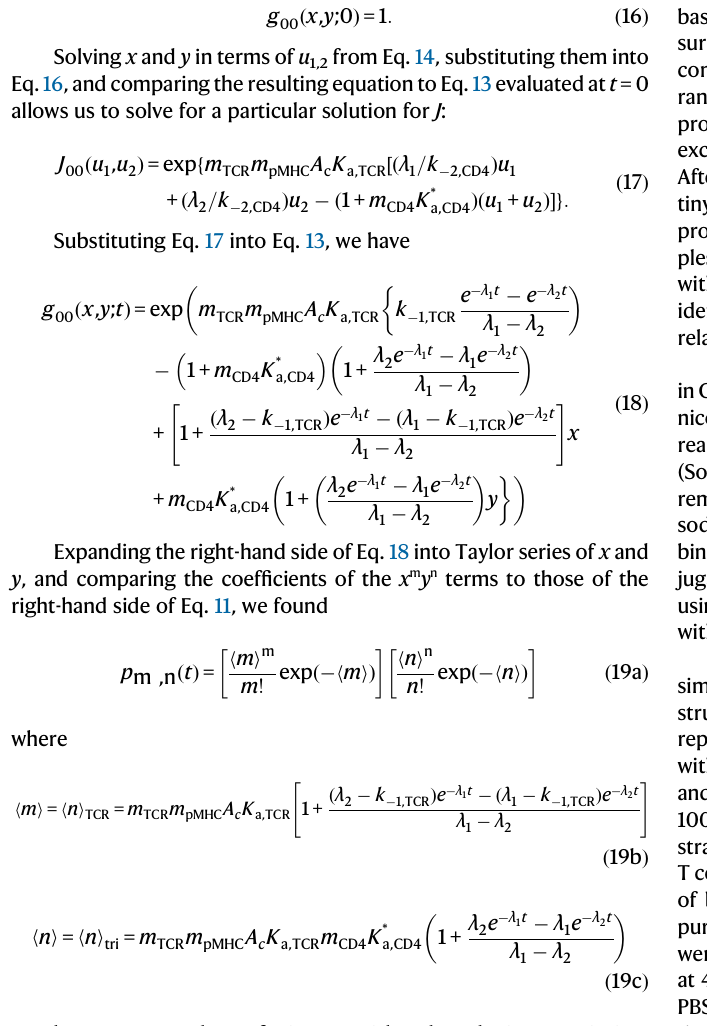
Linear fi ttings of data in Fig. 2d, Fig. 5b, Supplementary Fig. 1, and Supplementary Fig. 2c were implemented in Prism using linear regression to estimate the slope and y -intercept of the trend. Non- linear fi ttings of bimolecular kinetic equations to data in Fig. 1c,d were implemented in Prism using Non-linear regression to estimate the corresponding kinetic parameters. Gaussian fi tting of data in Fig. 5c was implemented in Prism using non-linear regression to estimate the Gaussian distribution and frequency of each distribution. For all fi tted parameters, fi tting error was presented as Standard Error (SE) assuming symmetrical con fi dence intervals. Fig. 2a were obtained by globally fi tting all data to Eqs. 1 & 2, which were also fi t to data in Fig. 3a, b, d, e, h. For the Fig. 3h case, the green and black data were globally fi t, the orange data was fi t on its own, and the blue data was fi t after constraining the off-rates obtained from the orange data fi t to avoid over fi tting. Best- fi t Pa ± SE (curves) in Fig. 3a was calculated from best- fi t <n> ± SE in Fig. 3b. p = 0.0563,